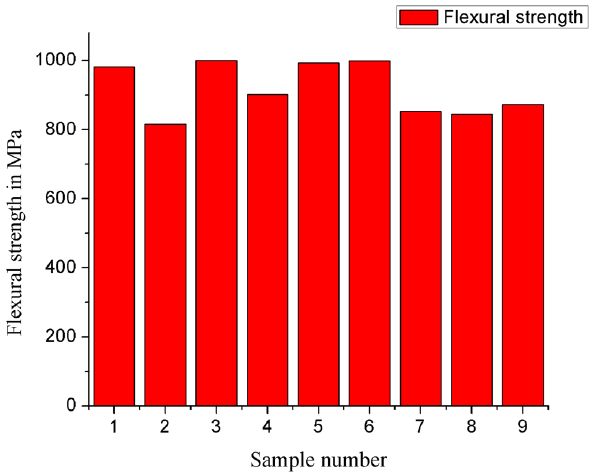
Figure 12: Schematic diagram showing the variation of fl exural strength for various